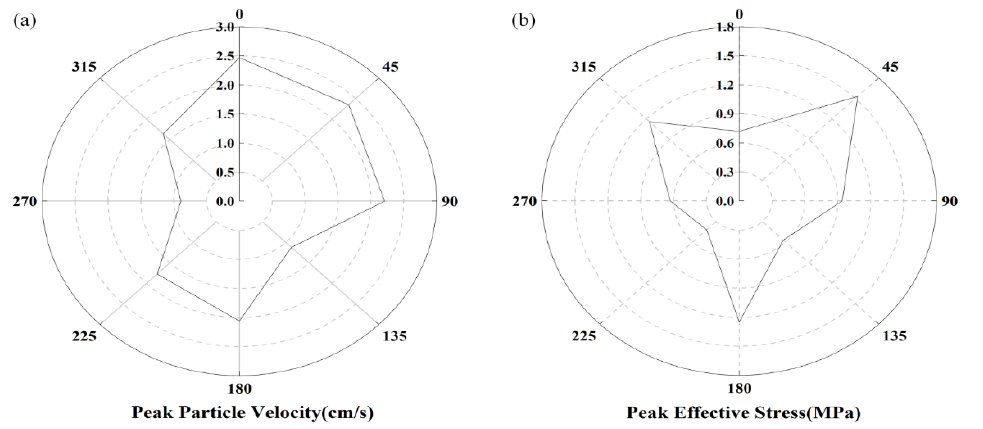
Figure 12. Pipeline cross-section dynamic response characteristics under hazardous construction conditions: ( a ) peak particle velocity; ( b ) peak effective stress. conditions: ( a ) peak particle velocity; ( b ) peak effective